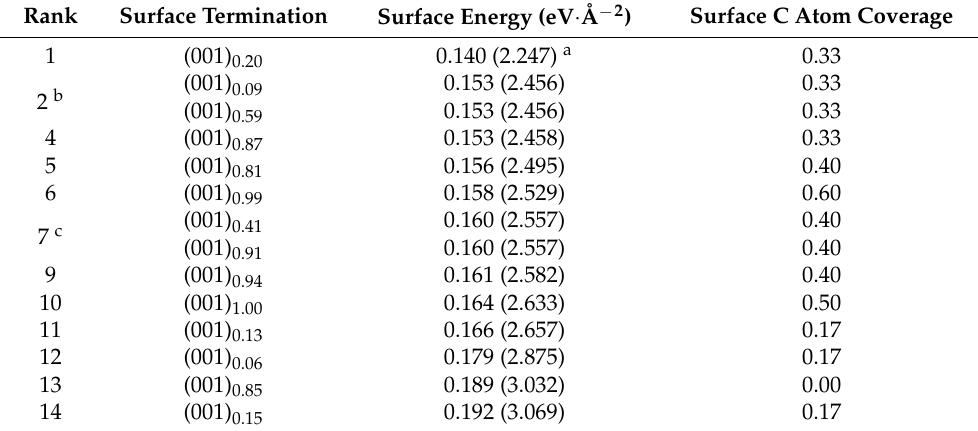
Table 1. Surface energies of o-Fe 7 C 3 (001) surfaces with various